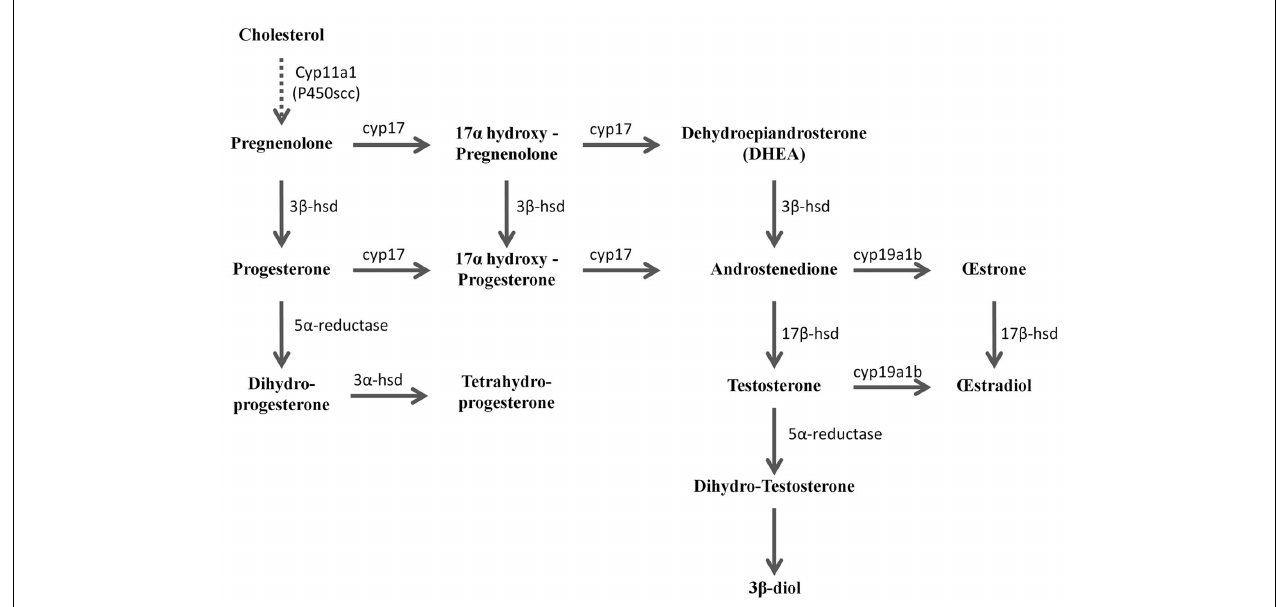
3 α -hydroxysteroid dehydrogenase; 3 β -HSD, 3 β -hydroxysteroid dehydrogenase D5–D4 isomerase; 3 β -diol, 5 α -androstane-3 β , 17 β -diol; 5 α -R, 5 α -reductase; 17 β -HSD, 17 β -hydroxysteroid dehydrogenase. Full line arrows show active steroidogenic biosynthetic pathway in the brain of adult zebrafish. Dashed line arrow show undetermined steroidogenic biosynthetic